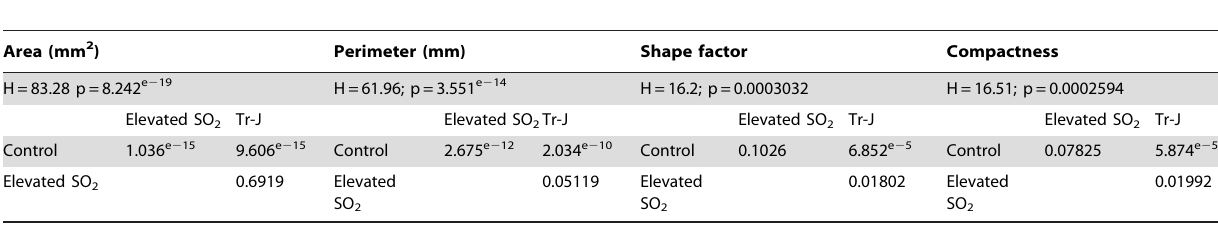
Table 3. Kruskal Wallis and Mann-Whitney pair-wise comparisons for each physiognomic trait in Agathis australis in the different simulated palaeoatmospheric treatments.